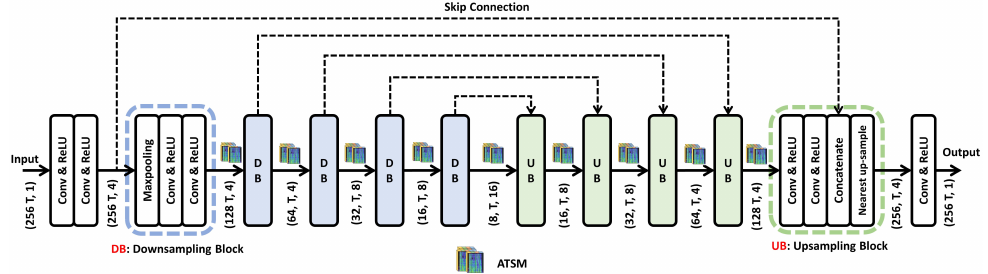
Figure 2. The detailed architecture of our general UNet design. ( F , T , C ) indicates F for frequency bins, T for temporal frames, and C for channels. When all convolutional layers are 1D and ATSMs are inserted after each DB/UB, it is our